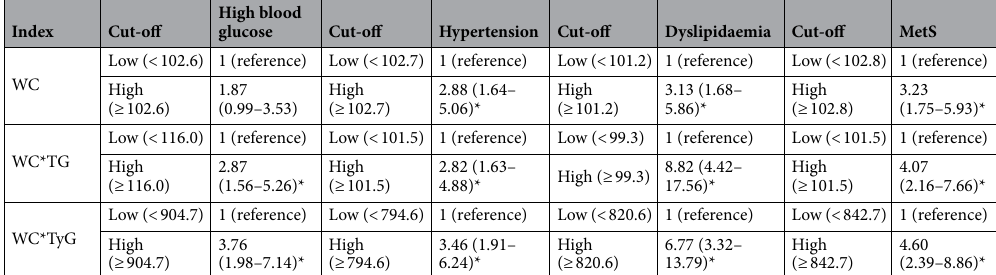
Table 3. Associations between indices (below/above this group specific cut-off point) with MetS and recognizable manifestations. * p < 0.05. Adjusted for sex, age, physical activity, family history of obesity, energy intake, adherence to a Mediterranean dietary pattern and education level.